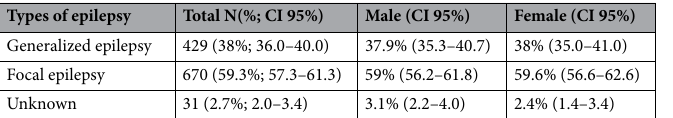
Table 3. Types of epilepsy.